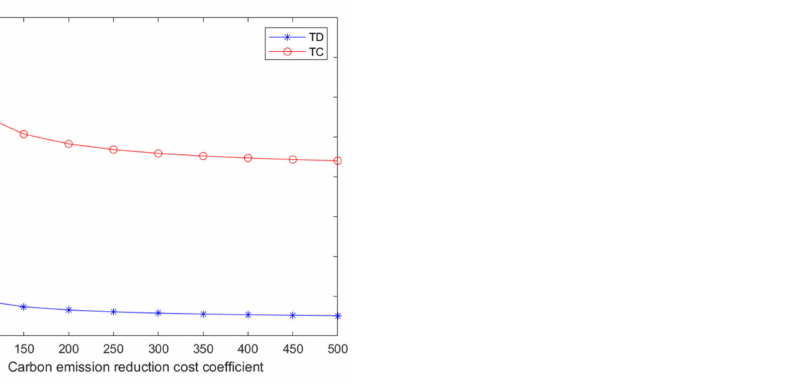
Figure 9. In the condition of centralized decision making with government carbon emission reduction subsidies, the impact of the carbon emission reduction cost coefficient on the expected return of model D and model C supply chains is shown.